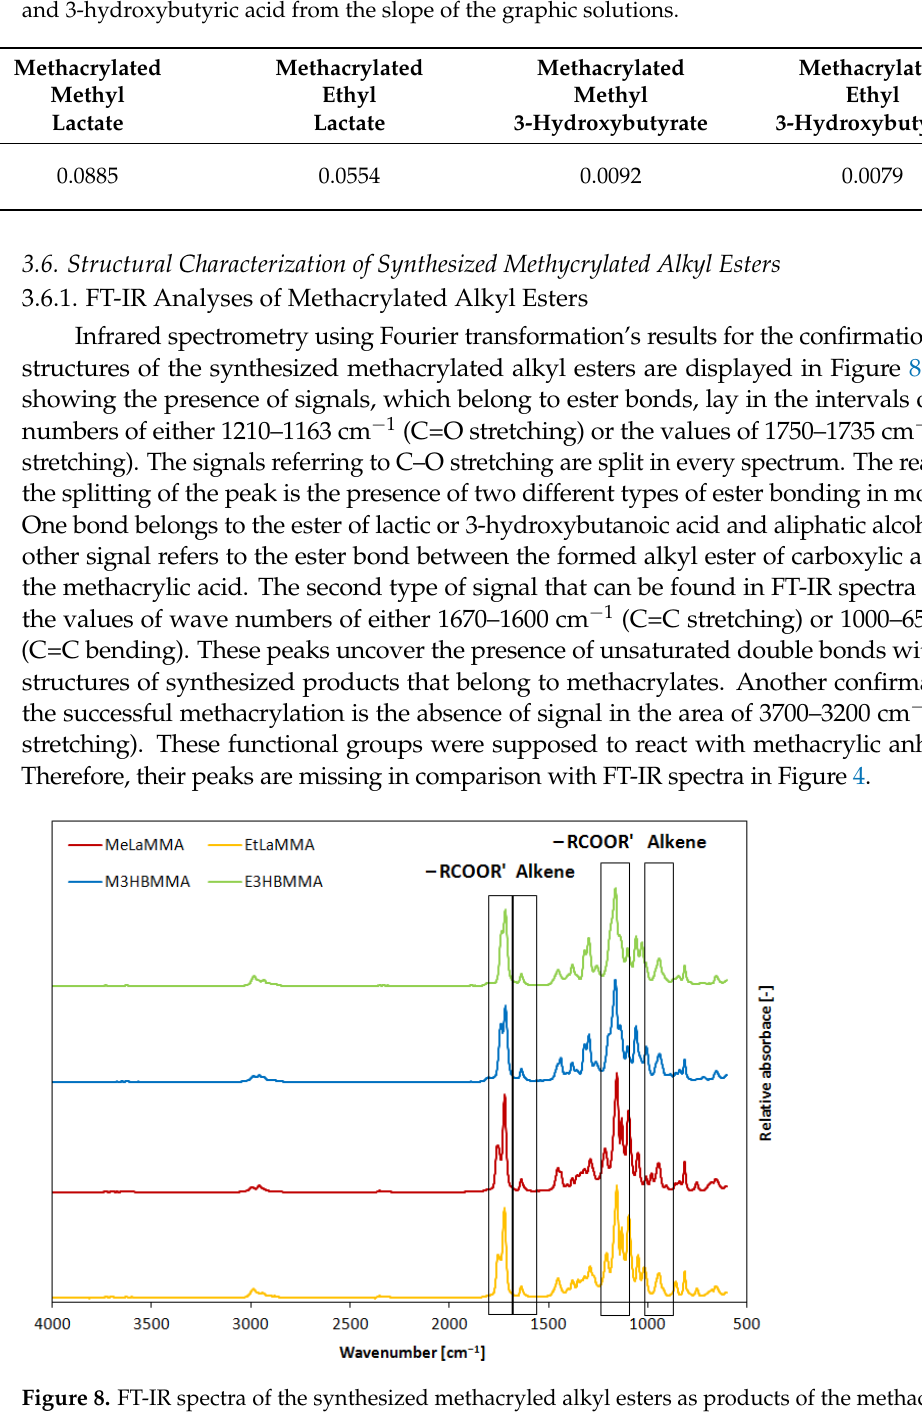
Figure 9. MS spectra of the synthesized methacrylated alkyl esters of lactic acid or 3-hydroxybutanoic acid. ( a ) Methacrylated methyl lactate (MeLaMMA); ( b )methacrylated ethyl lactate (EtLaMMA); ( c ) methacrylated methyl 3-hydroxybutyrate (M3HB); ( d ) methacrylated ethyl 3-hydroxybutyrate (E3HB).